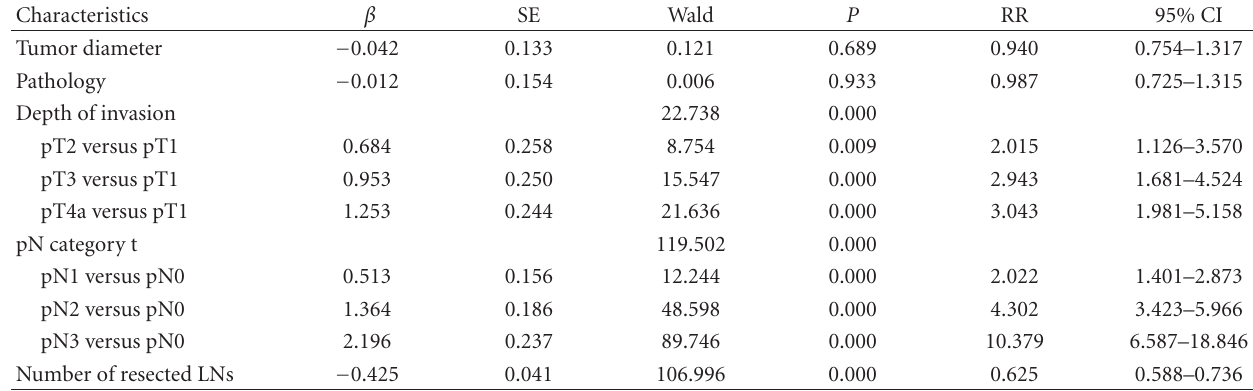
Table 3: Multiple stepwise regression analysis with the Cox proportional hazards model.